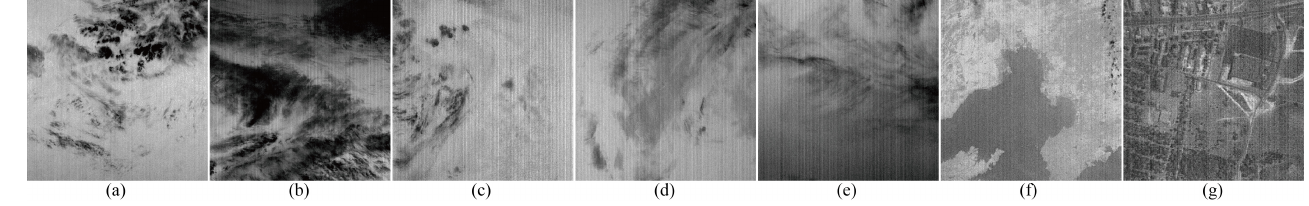
Figure 5. Eight testing images respectively from Terra MODIS data (( a – c ) named as STM1 , STM2 , and STM3 ), Aqua MODIS data (( d – f ) named as SAM1 , SAM2 , and SAM3 ), Hyperspectral data (( g ) Washington DC Mall, SWDCM ), and Multispectral data (( h ) Washington DC, SWDC ).